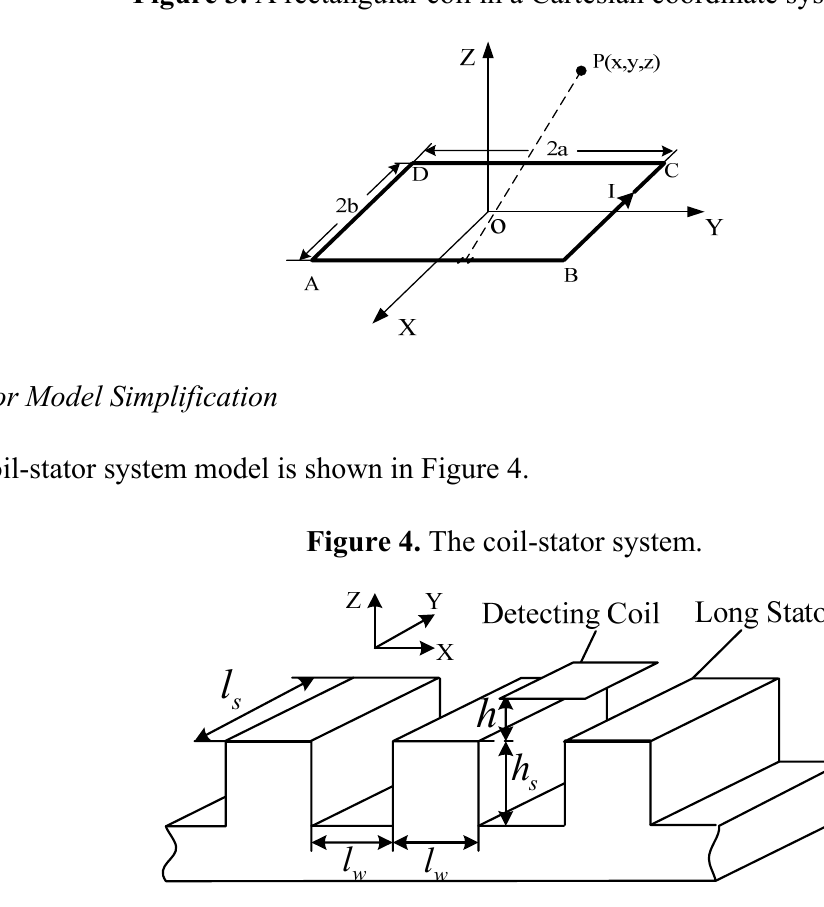
Figure 3. A rectangular coil in a Cartesian coordinate system.